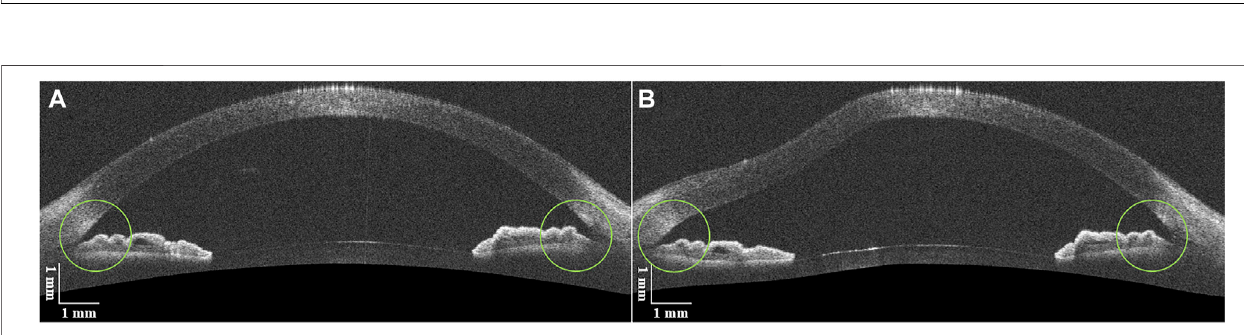
FIGURE 4 | DAS-OCT images of a normal subject eye. (A) , image before the air puff; (B) , image after the air